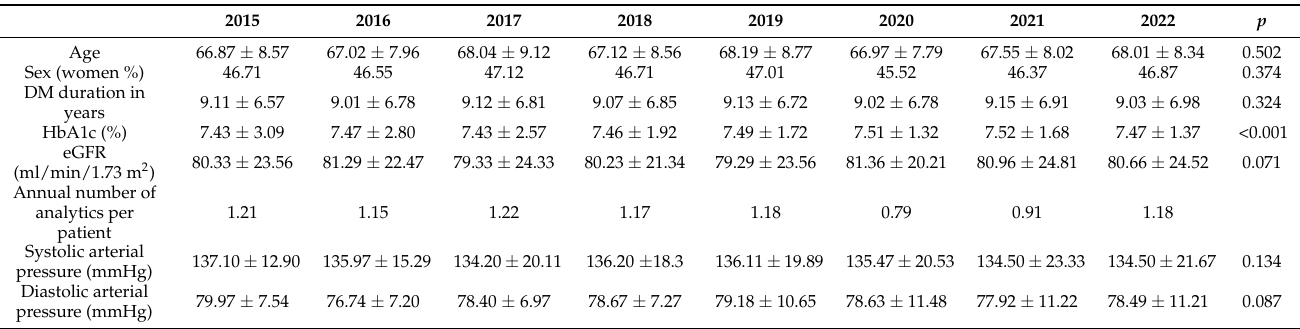
Table 2. HbA1c, arterial systolic and diastolic tension and eGFR estimated glomerular filtration rates along the seven-year follow-up